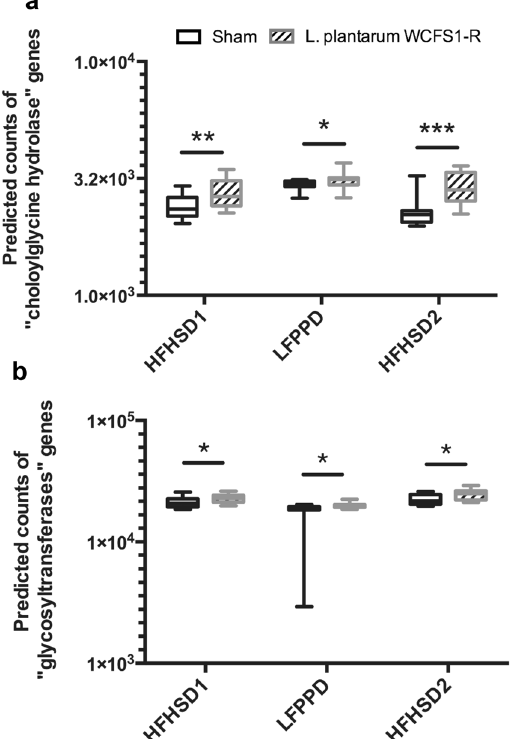
Figure 7. Pathways specifically enriched in L . plantarum WCFS1-R fed mice during all dietary periods. Metagenomics prediction was performed using PICRUSt 19 , a software to infer the gene content from bacterial community composition data. The whiskers of the box plot indicate the minimum and maximum